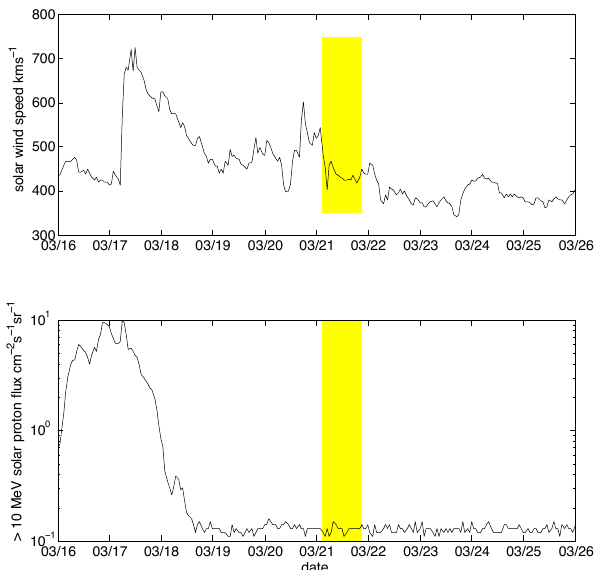
Figure 7. Solar wind speed and flux of > 10MeV protons from the OMNI 2 data set (http://omniweb.gsfc.nasa.gov/) between 16 and 25 March 2013. The yellow area corresponds to the model/observation period in Fig. 6.